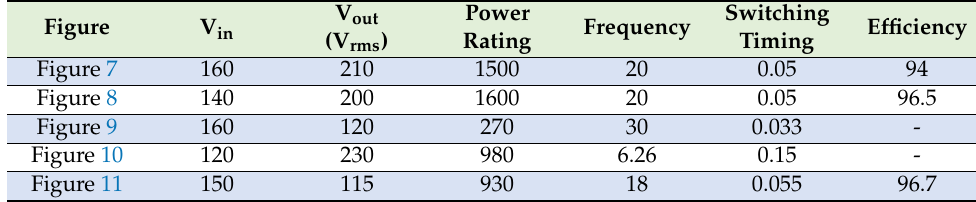
Figure 11. Boost with feedback integrated and dual grounded transformerless inverter. Table 1. Comparative study on ratings of two-stage inverter